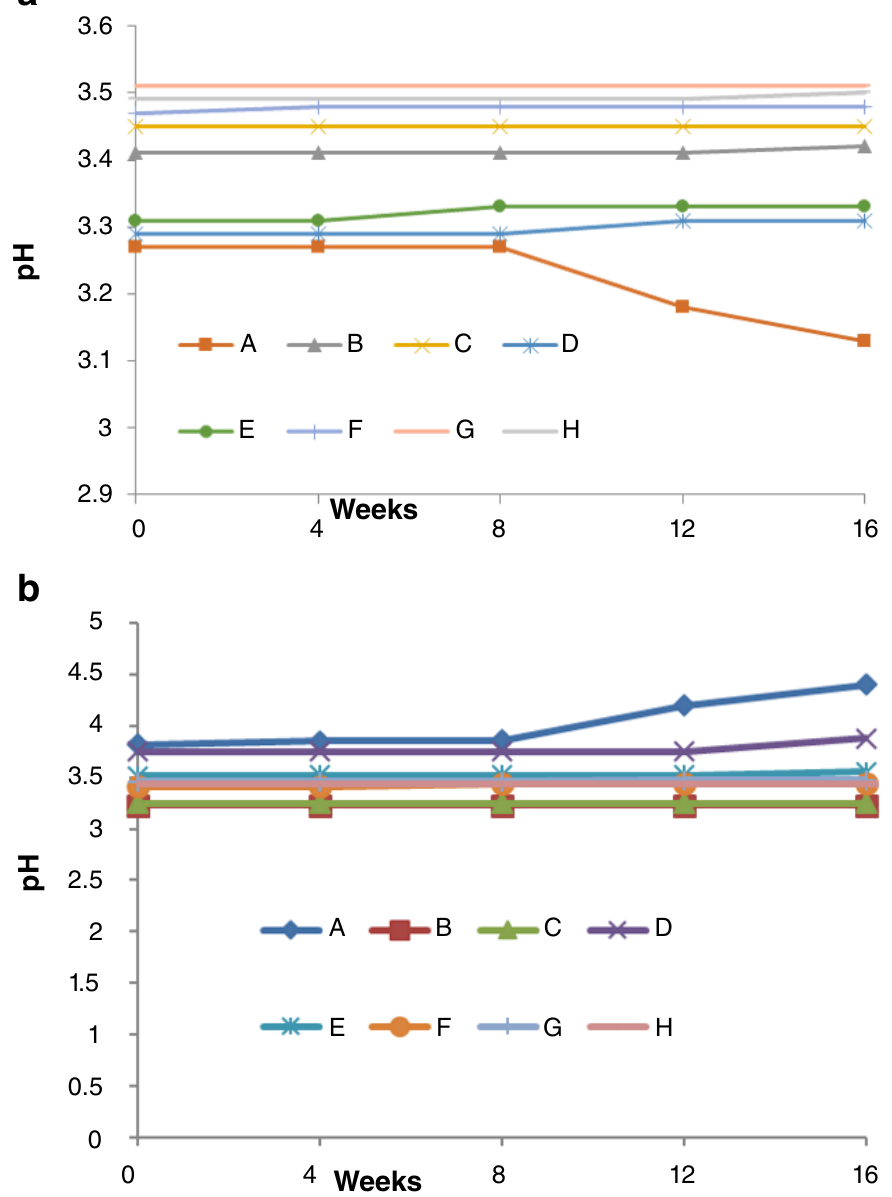
Figure 1. pH of Ogi flour made with ( a ) maize and ( b ) sorghum with Garlic and Ginger. Sample codes: A: Ogi Flour, B: Ogi Flour + 2% Garlic, C: Ogi Flour + 4% Garlic, D: Ogi Flour + 2% Ginger, E: Ogi Flour + 4% Ginger, F: Ogi Flour +2% Garlic + 2% Ginger, G; Ogi Flour+2% Garlic + 4% Ginger, H: Ogi Flour +4% Garlic + 2% Ginger.